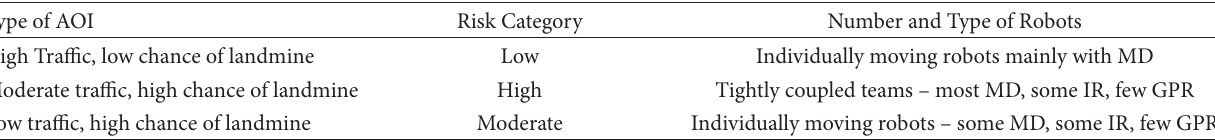
Table 2: Classification of different types of AOI in COMRADES depending on risk to human